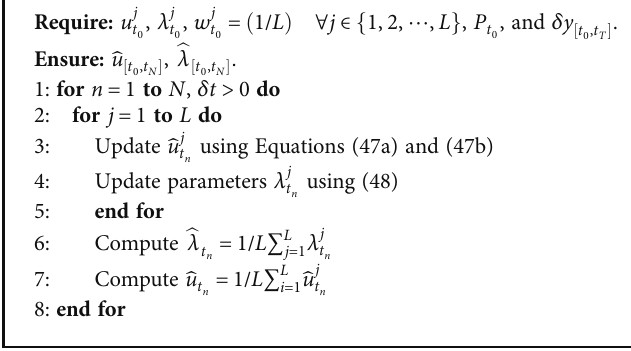
Algorithm 4: KBF-EnKBF dual fi lter.